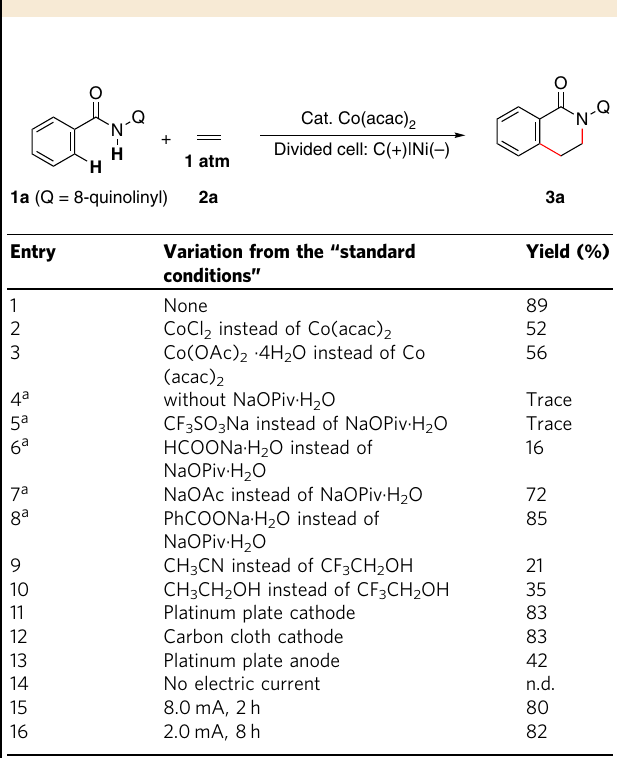
Table 1 Effects of the reaction